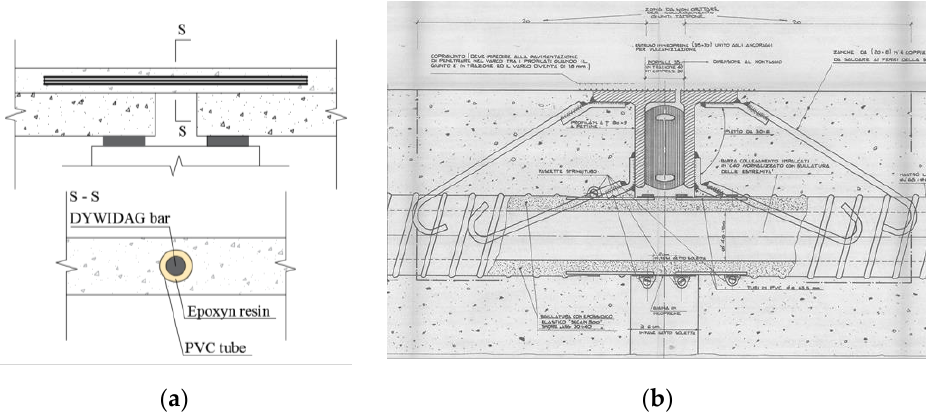
Figure 7. ( a ) Schematic representation of debonded rebar link slab and ( b ) detail of the joining ele- ments between the decks (link slabs). Source: design project of the road links among SS76 road, A14 highway, Falconara airport, and SS16 road, ANAS, 18.02. 1986 [44].